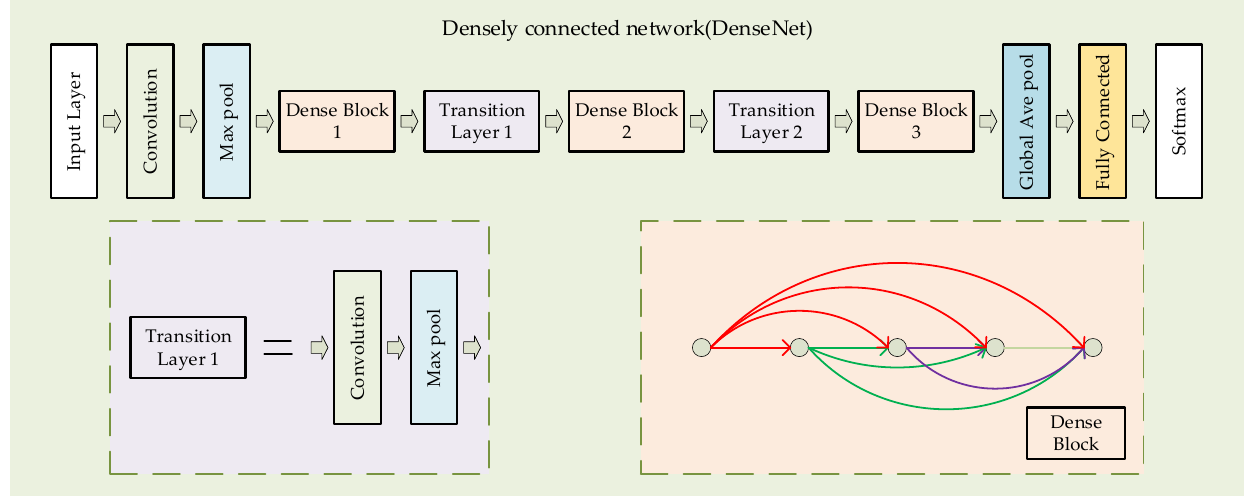
Figure 1. Structure of DenseNet.